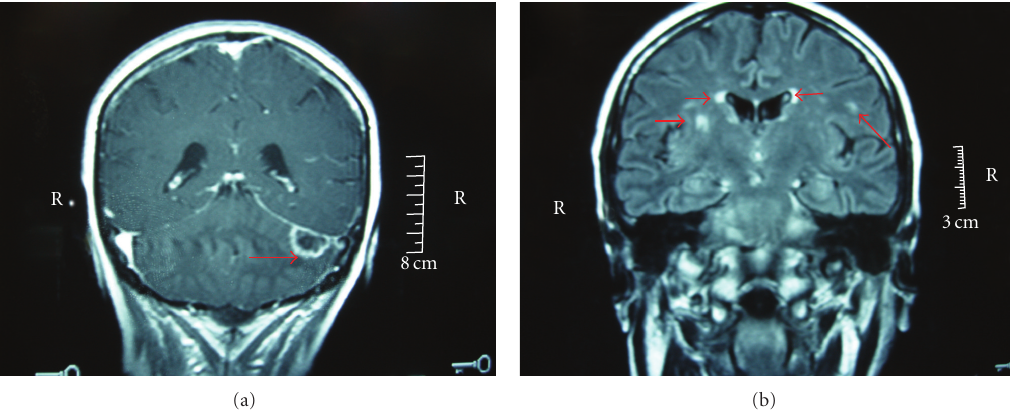
Figure 1: Cerebral MRI: (a) coronal view T1 with gadolinium injection: left cerebellar nodular lesion with central necrotic zone and peripheral contrast enhancement. (b) Coronal view T1 without gadolinium injection: periventricular localization of multiple cerebral hypersignal nodular lesions.